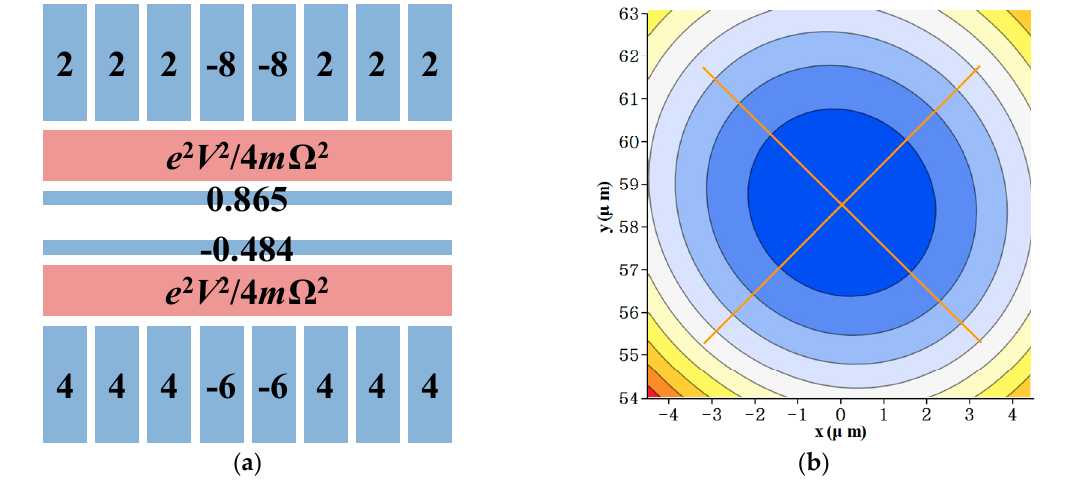
Figure 10. Investigation of the effects of the DC voltages at the ion position. ( a ) applied DC voltage set; ( b ) axes tilt result of 44.7 º . The tilt angle is achieved by computing the Hessian matrix of the total trap potential and finding the eigenvalues.